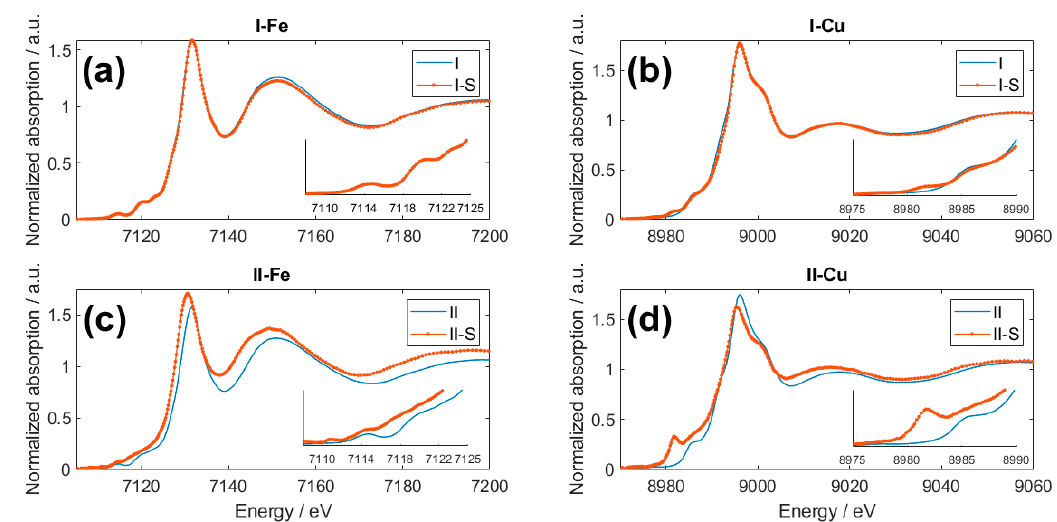
Figure 5. X-ray absorption spectroscopy spectra of samples I and II before and after contact with the electrolyte solution (S), taken at Fe and Cu K-edge after six months. ( a ) sample I at Fe K-edge ( b ) sample I at Cu K-edge ( c ) sample II at Fe K-edge ( d ) sample II at Cu K-edge.